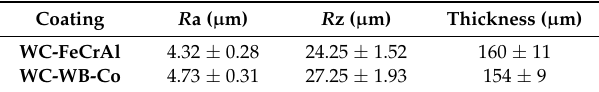
Table 5. Microgeometry and thickness of the coatings.